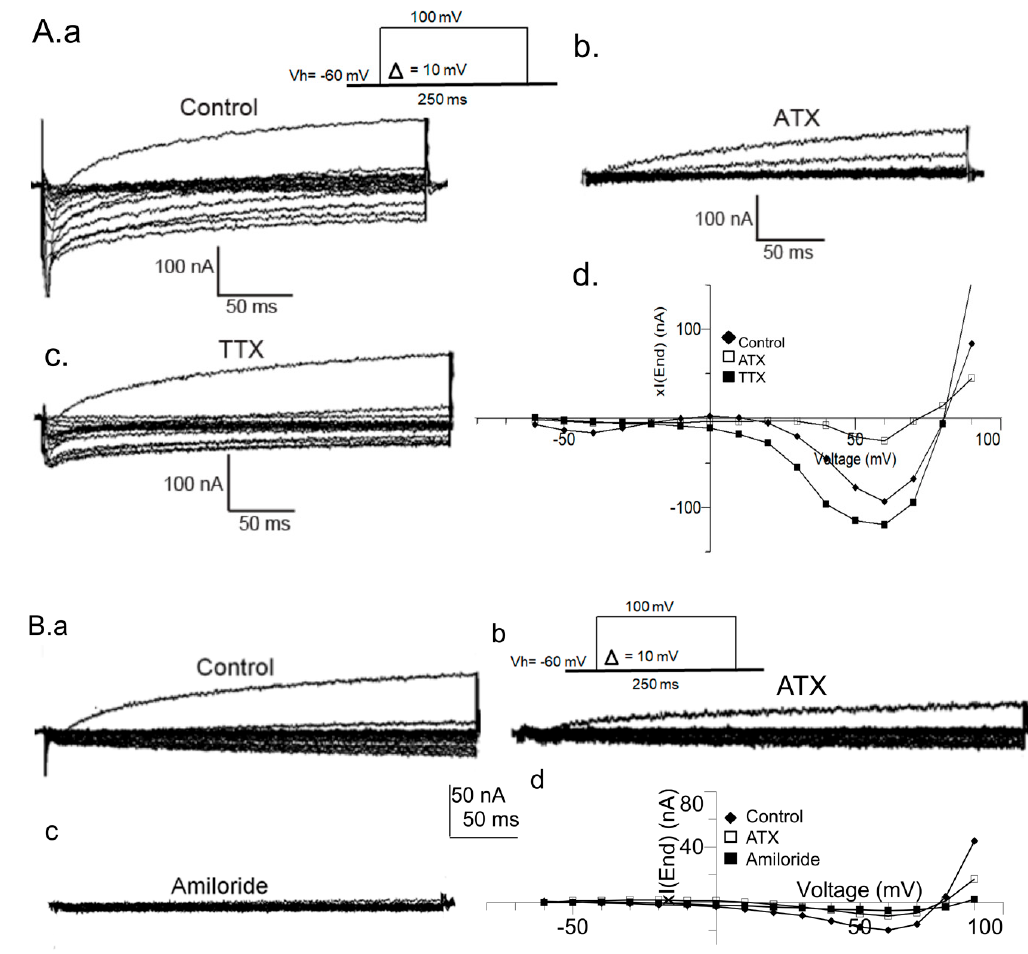
Figure 3. ATX inhibits voltage gated sodium channels that are sensitive to amiloride in Xenopus oocytes. TEVC currents were recorded with [Na + ] (82.5 mM) in the bath. In ( A ) Current traces families in control conditions ( a ) in the presence of ATX ( b ) with ATX removed and replaced by TTX ( c ). Current-potentials relationships constructed from a, b and c show that ATX inhibits the current amplitude contrary to TTX ( d ). In ( B ) Current families trace in control conditions ( a ) in the presence of ATX ( b ) and then in presence of amiloride ( c ). Current-potentials relationships constructed from a, b and c show that ATX inhibits the current amplitude in the same manner as amiloride ( d